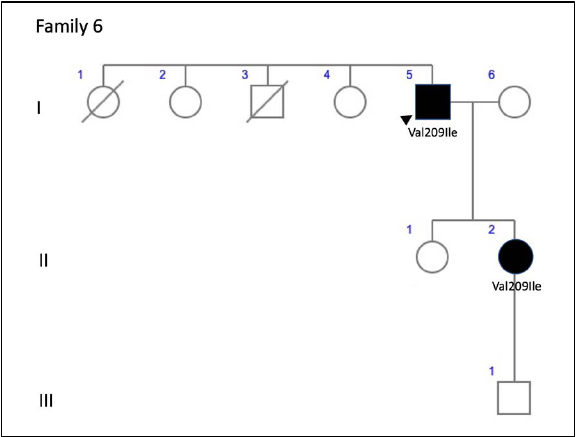
Figure 15. The family 6 pedigree.